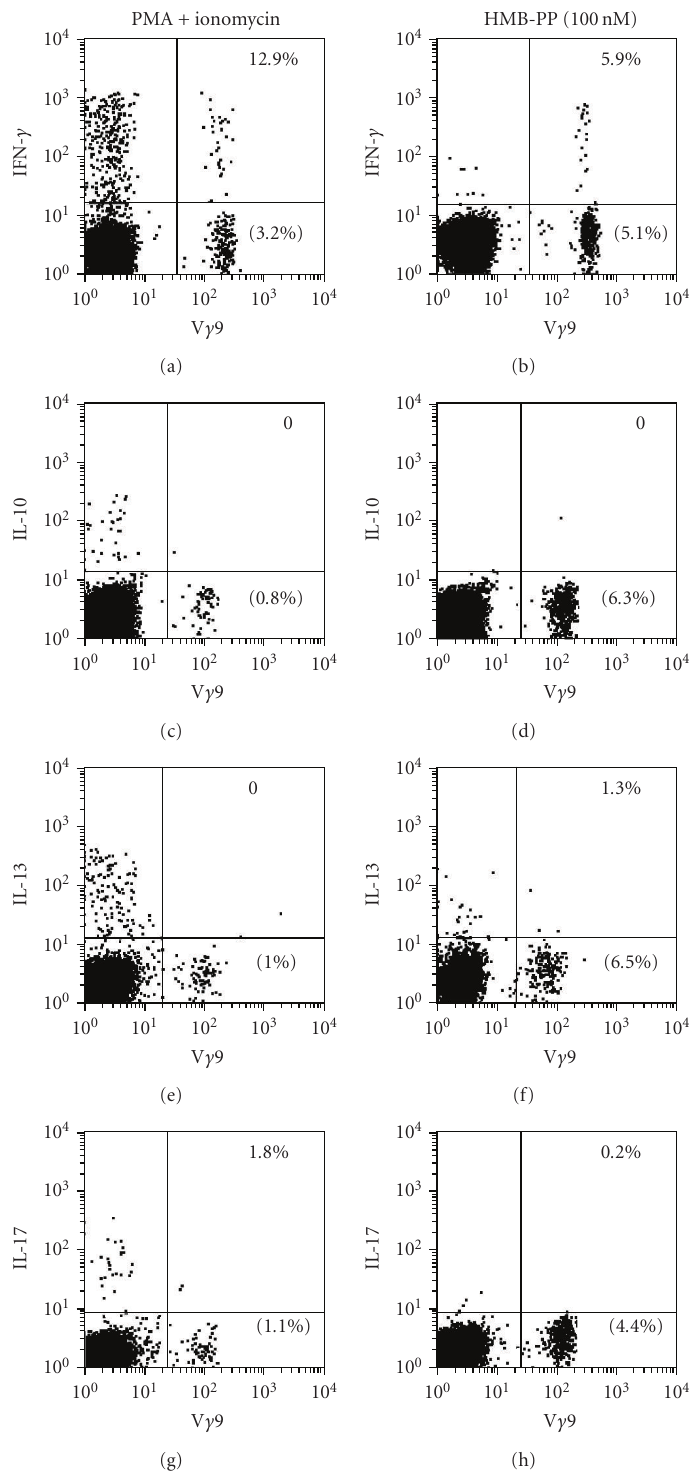
Figure 1: V γ 9V δ 2 T cells rapidly produce IFN- γ , but not IL-10, IL-13, nor IL-17, in response to PMA and ionomycin or pyrophosphate stimulation. (a) Flow cytometry dot plots showing IFN- γ , IL-10, IL-13, and IL-17 expression by V γ 9 + and V γ 9 − PBMC after 4-hour stimulation with PMA and ionomycin or HMB-PP, in the presence of brefeldin A. Plots are representative of experiments on PBMC from 8 donors. Numbers in the lower right hand quadrants indicate the percentages of lymphocytes that express the V γ 9 TCR. Numbers in the upper right hand quadrants indicate the percentages of V γ 9 + T cells that produce each